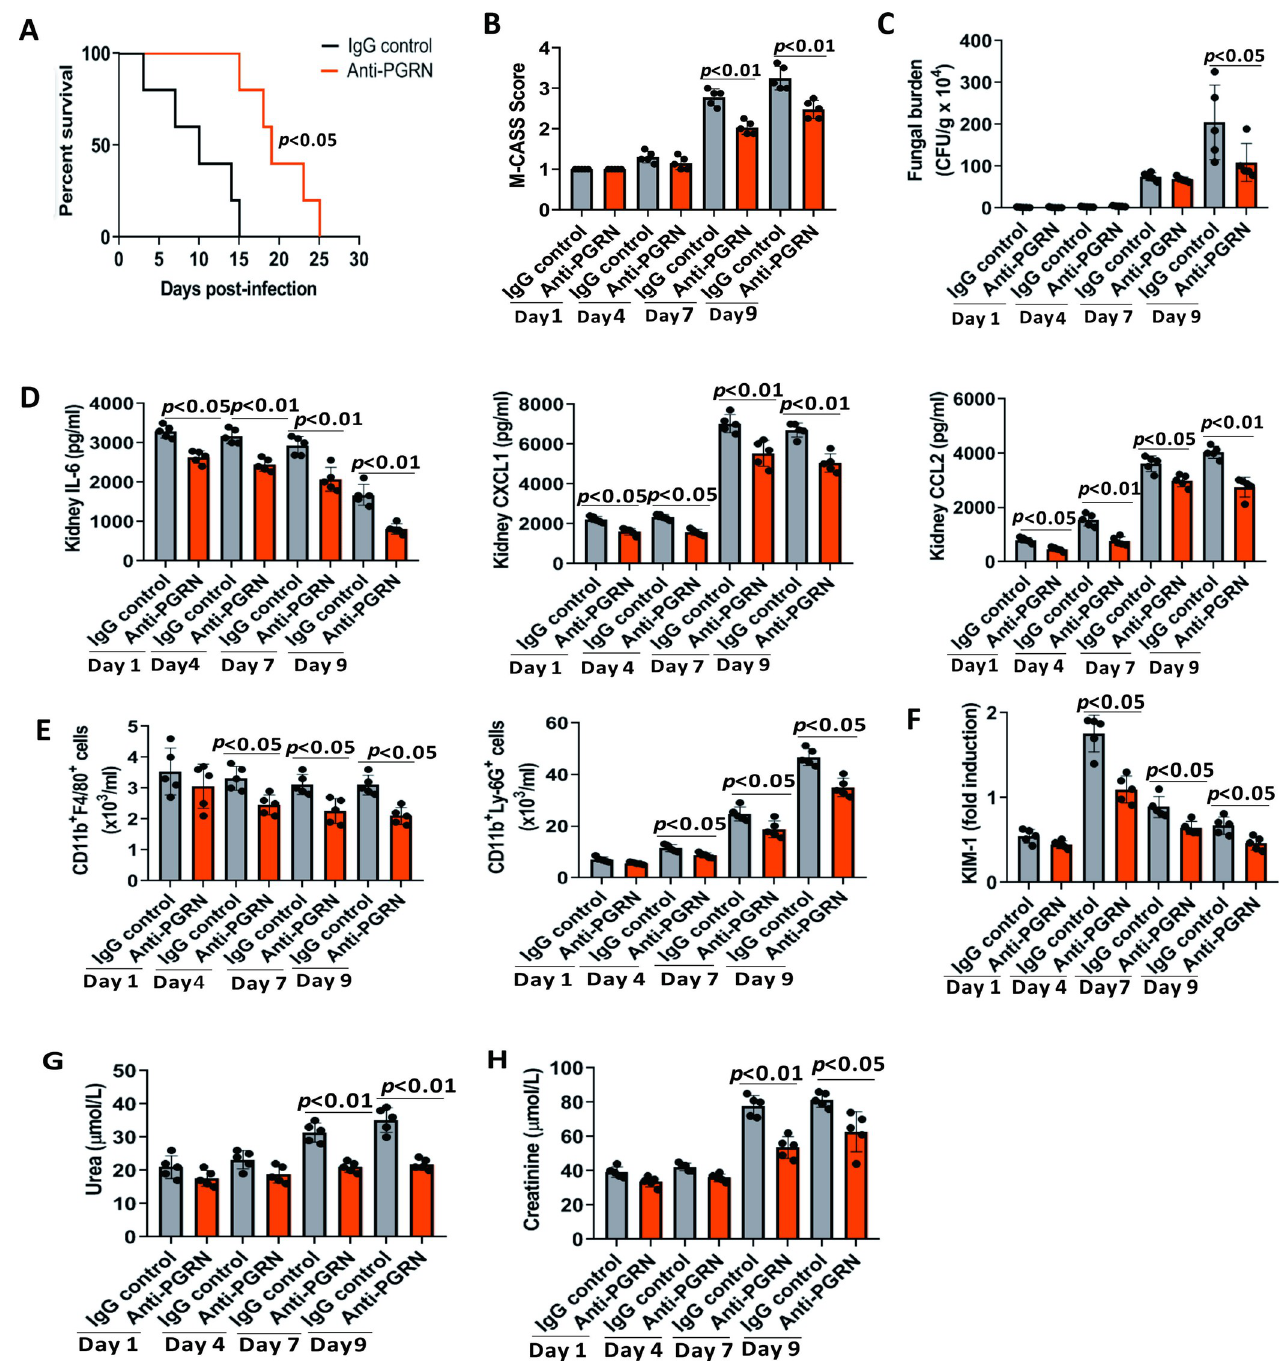
Fig 6. PGRN blockade by anti-PGRN antibody showed therapeutic effect on invasive C . albicans infection. WT mice were intravenously injected with 1 × 10 6 CFU of C . albicans , and PGRN blockade was performed by intraperitoneally administration of 5 μ g of anti-PGRN monoclonal antibody on day 0 (same day as C . albicans infection), followed by a booster dose of 2.5 μ g 24 hour later. (A) Survival of these mice (n = 10 for each group) was monitored. (B) Mouse Clinical Assessment Score for Sepsis (M-CASS) scores of WT mice (n = 5) treated with or without anti-PGRN antibody after intravenous infection with 1 × 10 6 CFU of C . albicans . (C) Kidney fungal loading was performed in WT mice (n = 5) treated with or without anti-PGRN antibody at the indicated times after intravenous infection with 1 × 10 6 CFU of C . albicans . (D) Kidney IL-6, CXCL1 and CCL2 levels were quantified by ELISA in WT mice (n = 5) treated with or without anti-PGRN antibody at the indicated times after intravenous infection with 1 × 10 6 CFU of C . albicans . (E) The numbers of macrophages (CD11b + F4/ 80 + ) and neutrophils (CD11b + Ly-6G + ) in the kidneys were quantified by flow cytometry analysis in WT mice (n = 5) treated with or without anti-PGRN antibody at the indicated times after intravenous infection with 1 × 10 6 CFU of C . albicans . (F) The gene expression levels of kidney injury marker-1 (KIM-1)